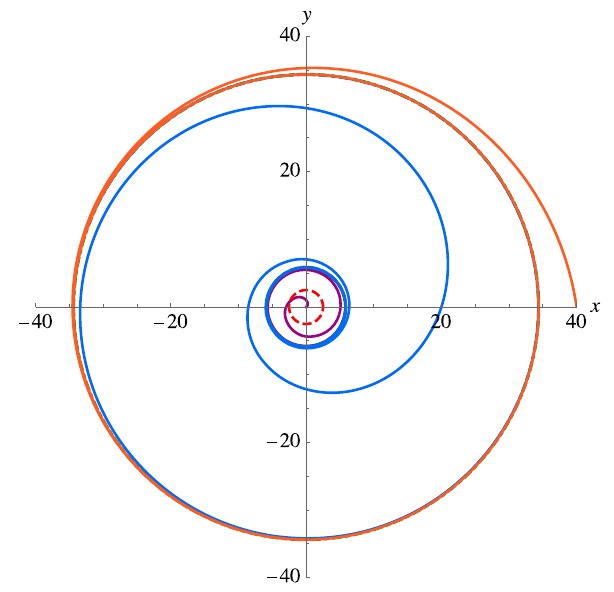
Fig. 16 The critical orbits of time-like geodesics for L = L C , E 2 = E 2 , and different initial points r j , in accordance with Fig. C